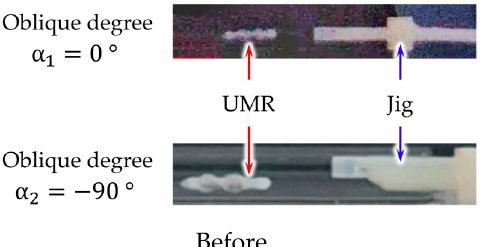
Before After Figure 12. Images of the UMR and the delivery catheter in the jig aligned in the glass tube before and after applying magnetic force and suction force (camera direction: α 1 = 0°, α 2 = − 90°).